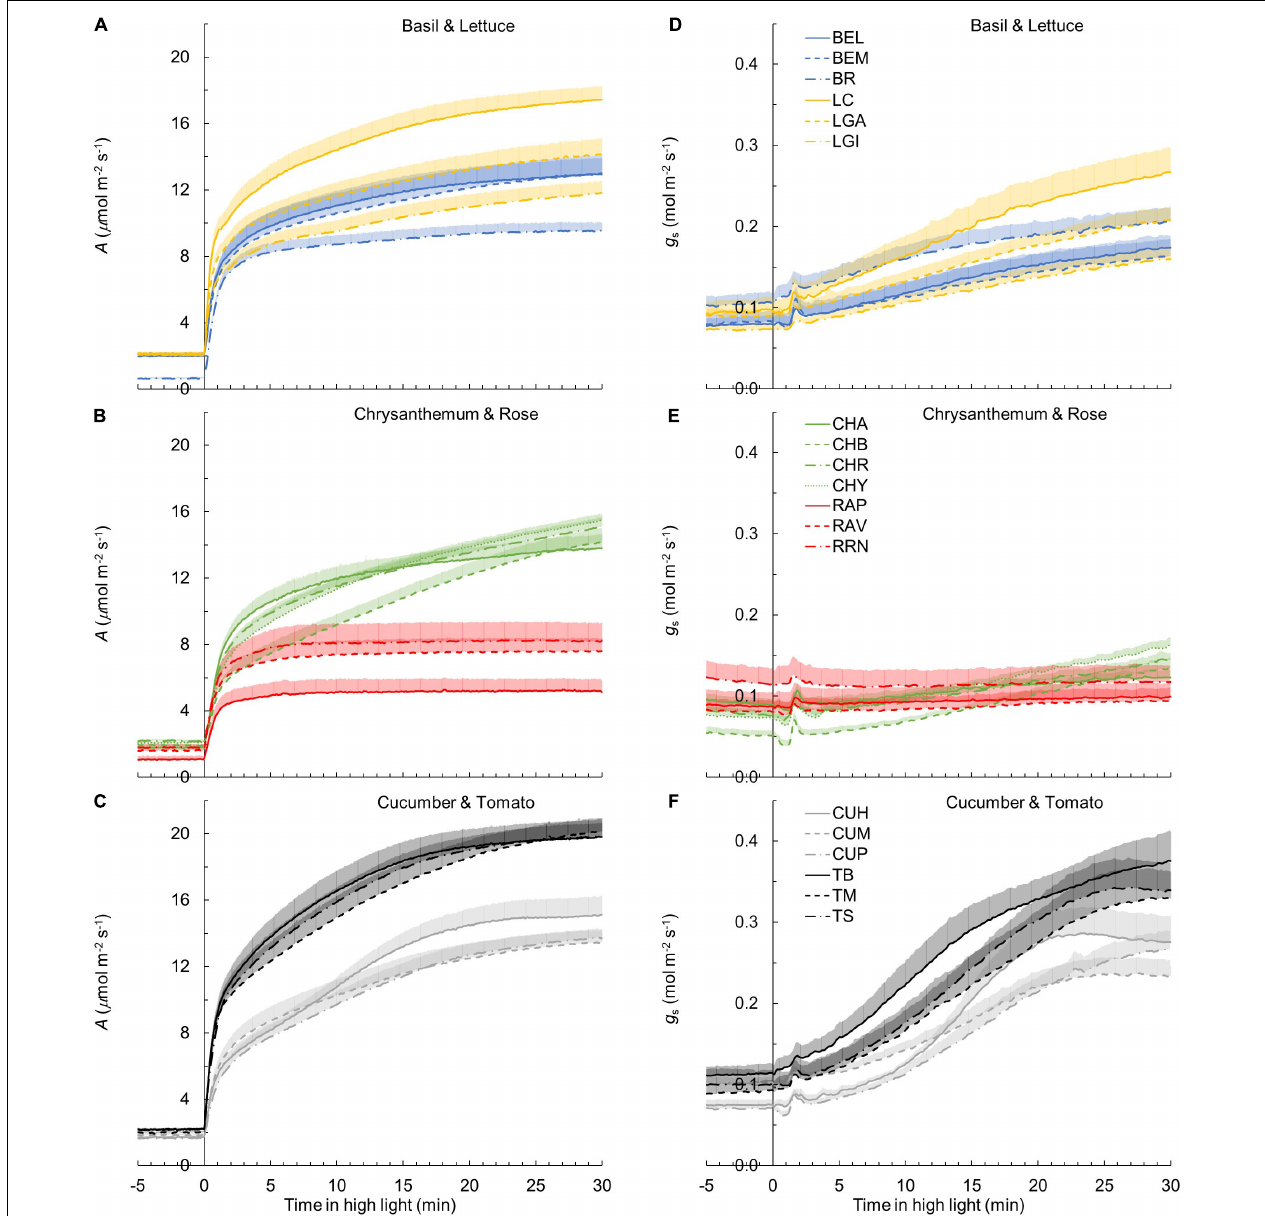
FIGURE 1 | Leaf photosynthesis rate ( A ) (A–C) and stomatal conductance g s (D–F) responses to a single-step change in irradiance in 19 horticultural genotypes of six species ( A,D : basil and lettuce; B,E : chrysanthemum and rose; C,F : cucumber and tomato; refer to Table 1 for full names of genotypes). Time zero indicates the moment when irradiance was increased from 50 to 1,000 µ mol m − 2 s − 1 . A and g s values were logged every 2 s. Line colors represent crop species, while line types differentiate between cultivars. Each curve represents the mean of 7–9 individual plants (mean +